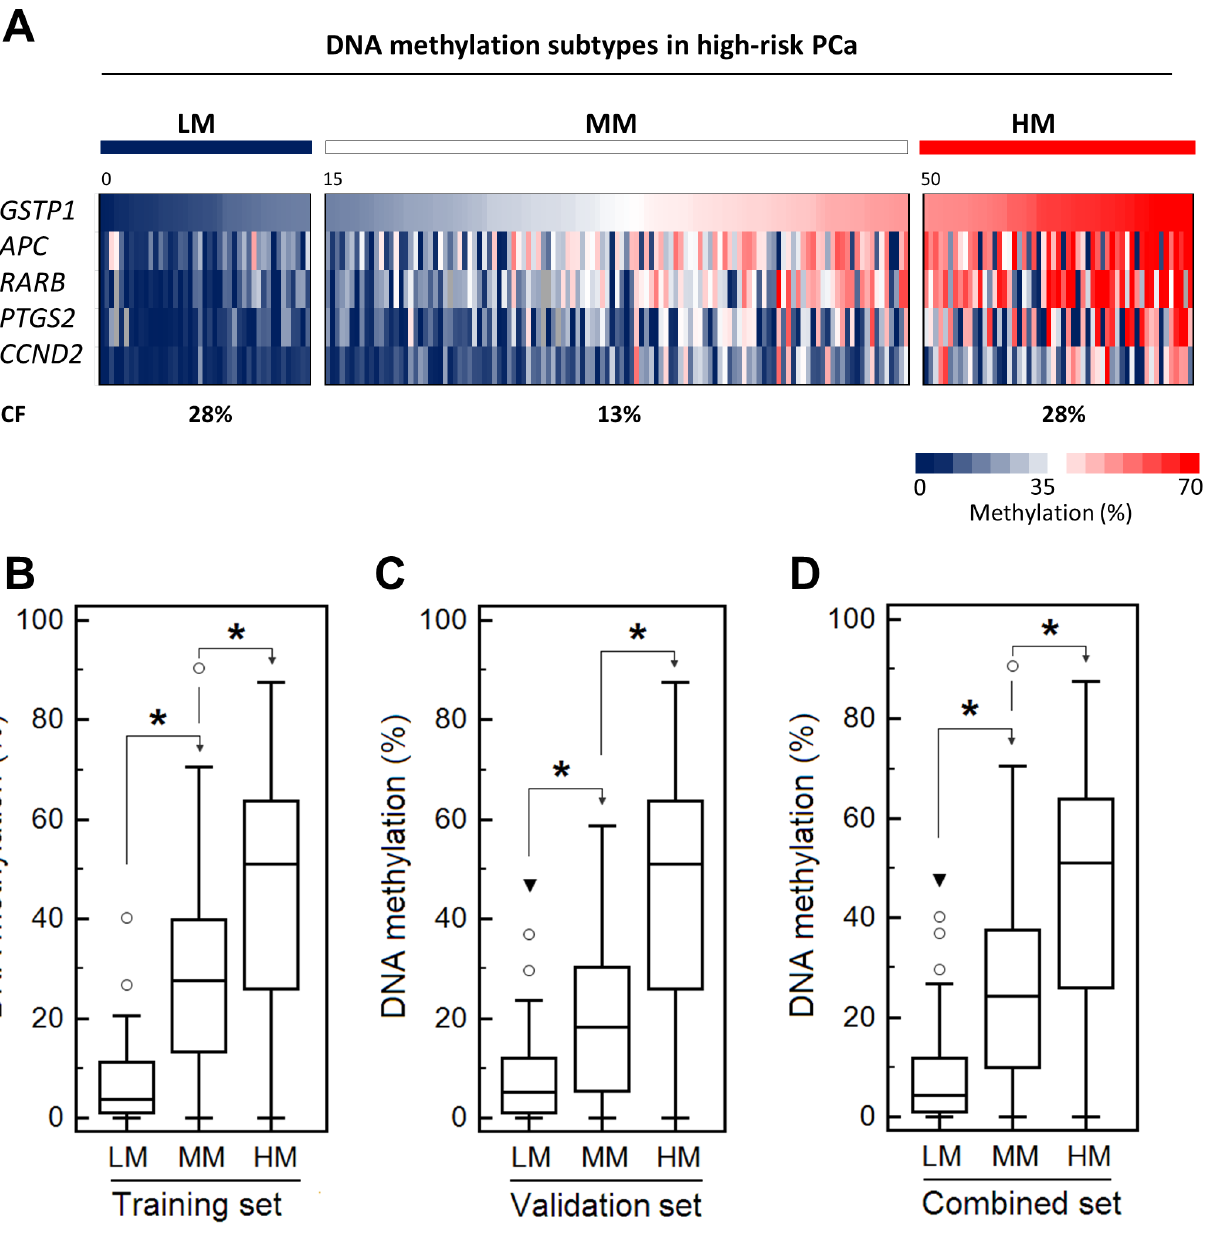
Fig 4. Methylation-guided sub-stratification of patients with high-risk PCa. (A) Color-coded representation of DNA methylation in tumors from the combined PCa1 + PCa2 cohort. The patients were ranked according to their GSTP1 methylation value and classified into low (LM), moderate (MM) and high (HM) methylation subtypes, based on GSTP1 methylation levels of < 15%, 15 – 50% and > 50%. The % of methylation of the other 4 marker genes is also shown. Grey boxes indicate missing values. (B-D) Box-whisker plots of the methylation of the 5 marker genes in the LM, MM and HM groups of the training, validation and combined cohorts. The boxes mark the 25th-75th percentiles, the median value (horizontal line in the boxes), and the minimal and maximal values (whiskers). Circles indicate the “ outside ” values (defined as those that are larger than the upper quartile plus 1.5 times the interquartile range). A filled triangle indicates a “ far out ” value (defined as that larger than the upper quartile plus 3 times the interquartile range). ( * ) P < 0.001, Mann-Whitney U